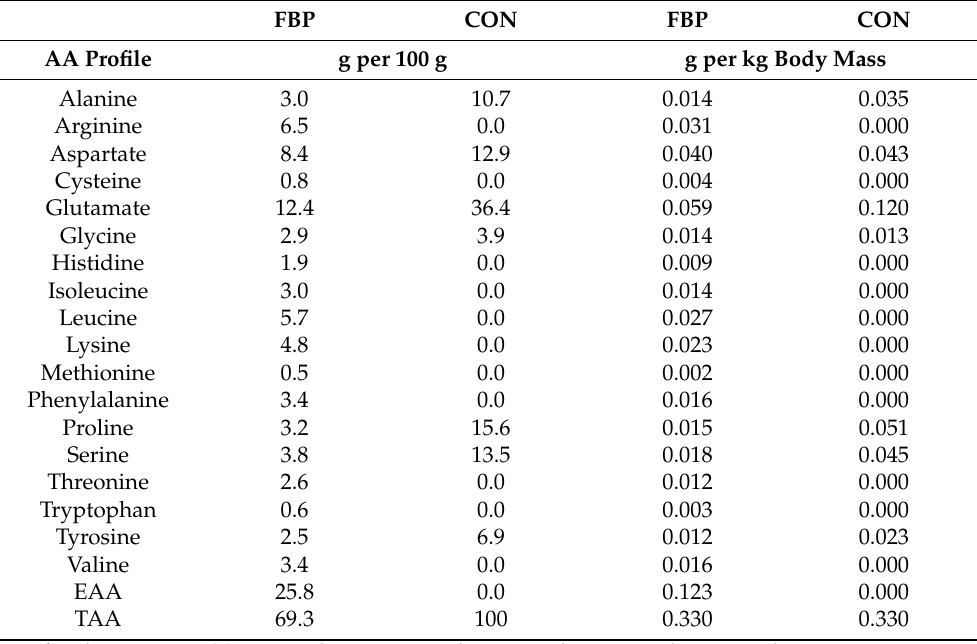
Table 1. Amino acid composition of the two